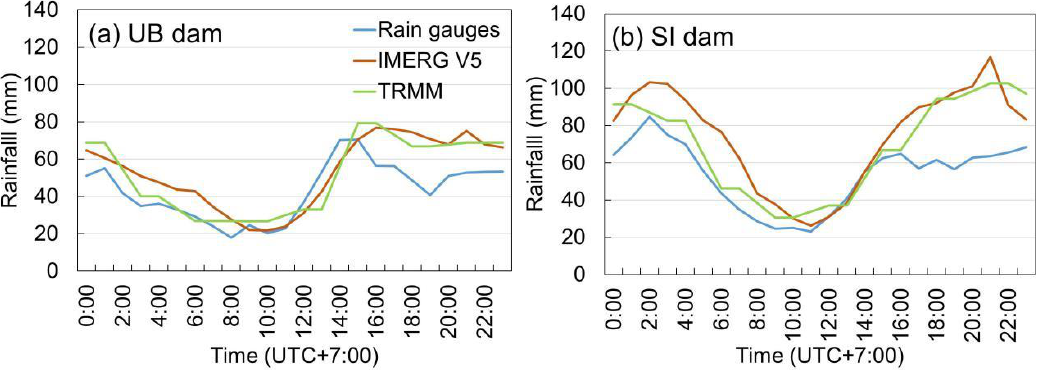
Figure 3. The four-year average hourly rainfall around ( a ) Ubolratana (UB) dam and ( b ) Sirindhorn (SI) dam from 12 March 2014 to 31 December 2017.